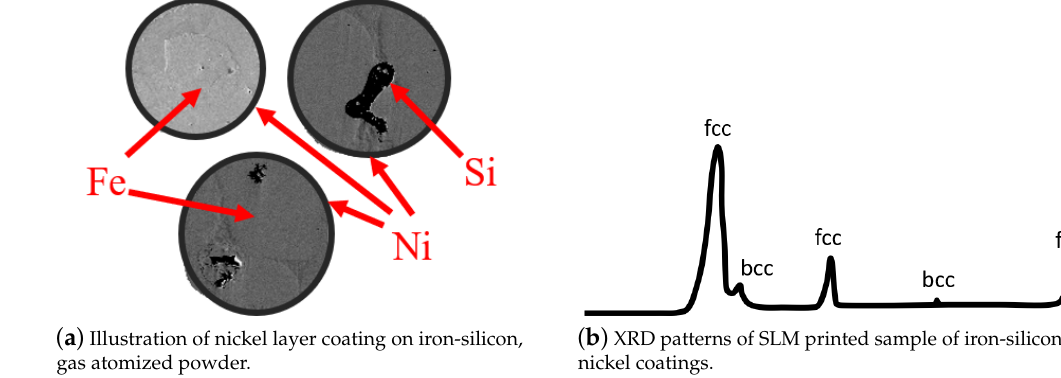
Figure 4. Illustration of impacts of using nickel iron silicon coated powder on the crystallographic structure of printed samples. Figures are adapted from